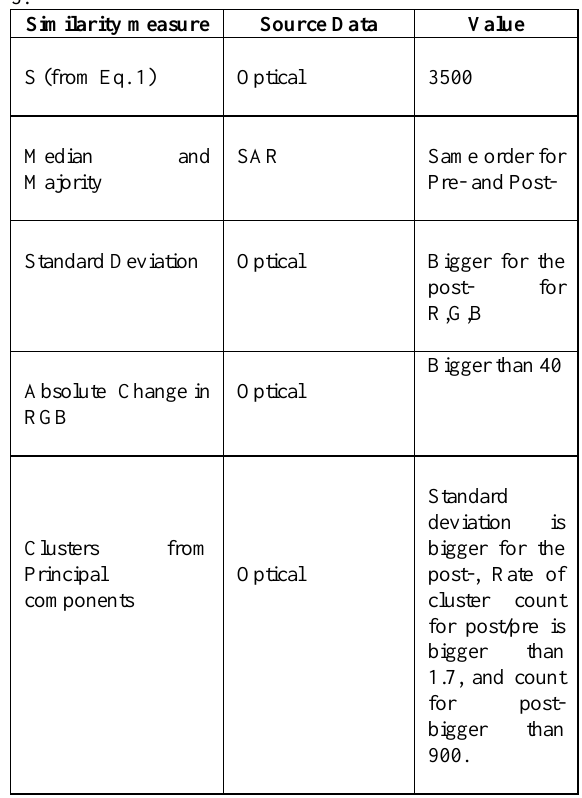
Table 3. Criteria for detecting the collapsed